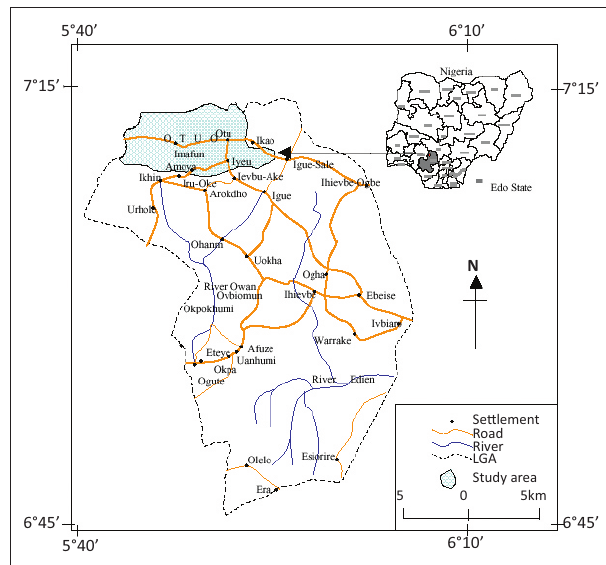
FIGURE 1: Map of Owan East Local Government Area showing the study